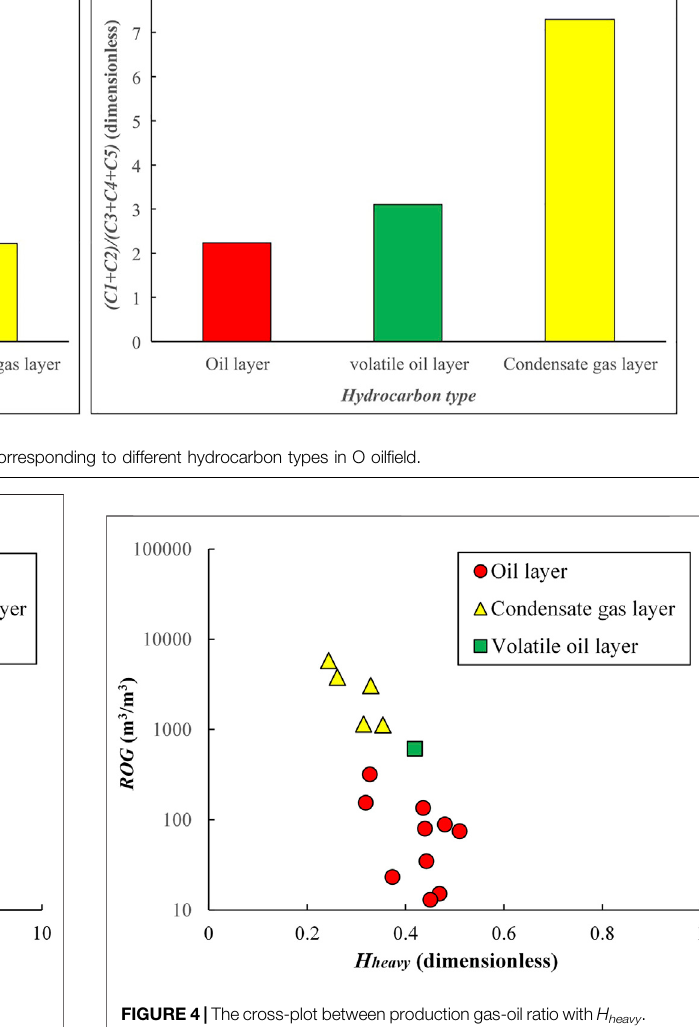
Frontiers in Energy Research |